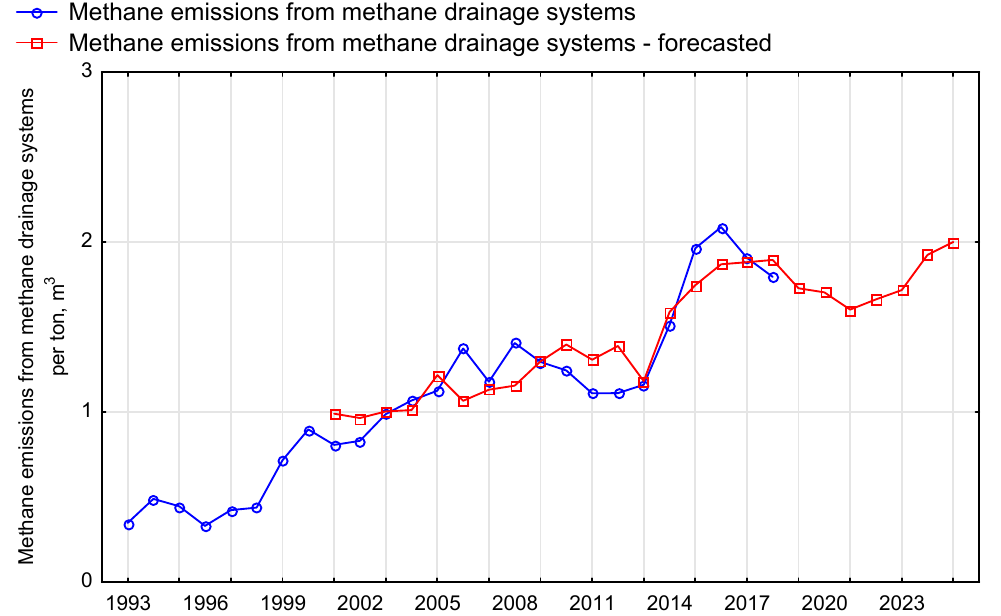
Figure 18. Actual and predicted amount of methane emissions from methane drainage systems into the atmosphere per ton of extracted coal.